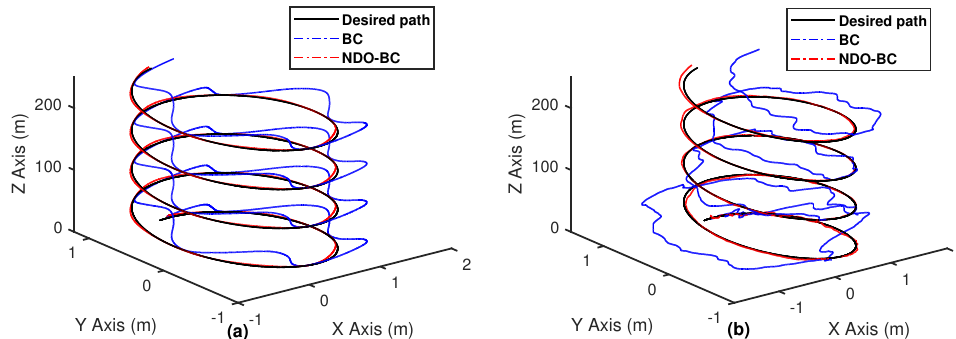
Figure 27. Comparison of nonlinear disturbance observer-based backstepping controller and nominal backstepping controller when ( a ) periodic disturbance ( b ) wind gust applied in Quadrotor